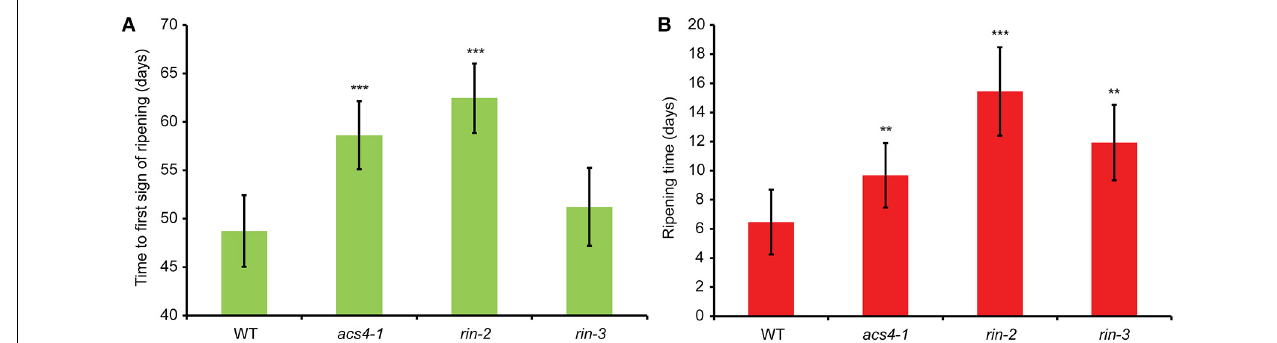
FIGURE 3 | Fruit ripening times. (A) Estimation of the number of days from open flower until the first sign of ripening, ± SD ( n = 24–60 fruits, i.e., 10–12 fruits from 2–5 plants per genotype). (B) Estimation of the length of the